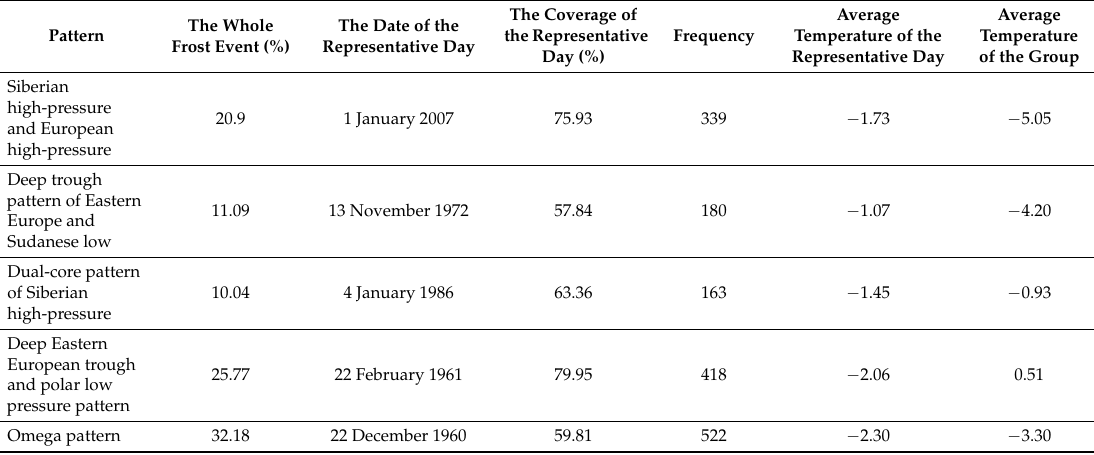
Figure 2. The dendrogram obtained through conducting group analysis on atmosphere thickness. Table 1. Features of the representative days for the five groups.